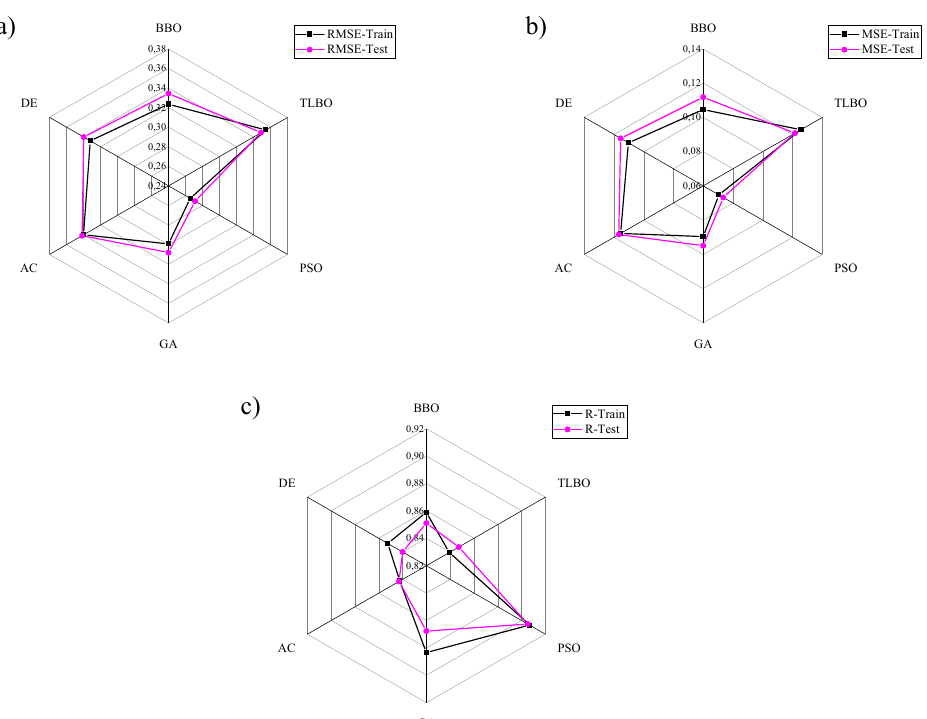
Figure 19. Comparison of the statistical indicators for six evolutionary algorithms to predict the motor load, ( a ) RMSE, ( b ) MSE, and ( c ) R.